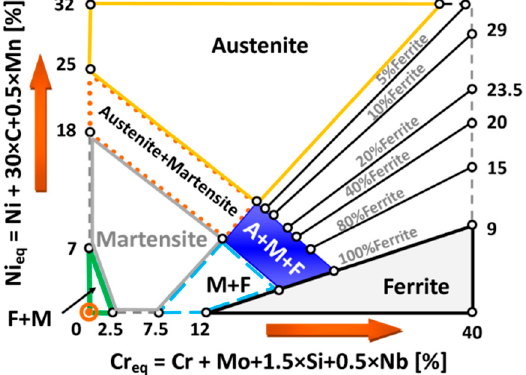
Figure 1. Schaeffler diagram with marked regions for components, A—Austenite, M—Martensite, Figure 1. Schae ffl er diagram with marked regions for components, A—Austenite, M—Martensite, F—Ferrite (based on F—Ferrite (based on [22]).